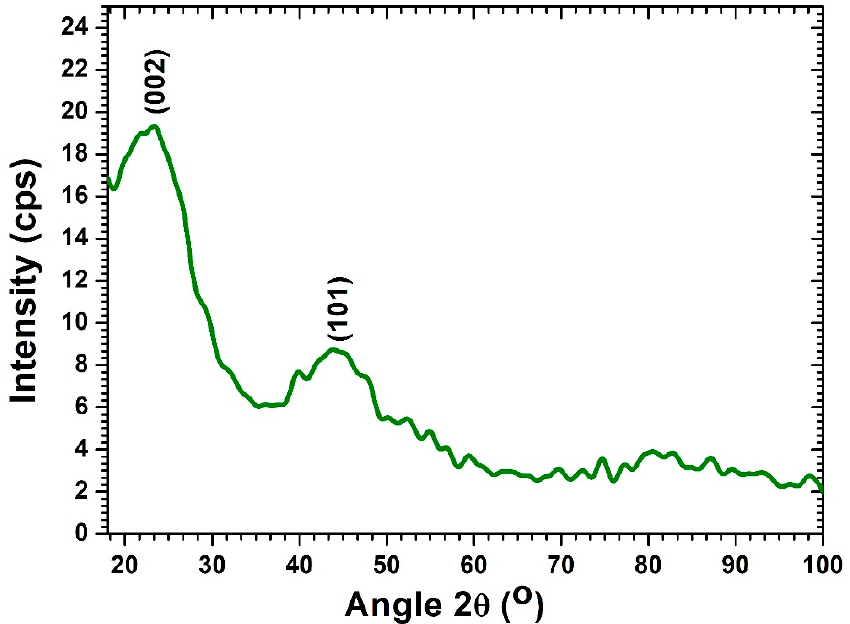
Figure 6. XRD of date pits derived AC-SY.